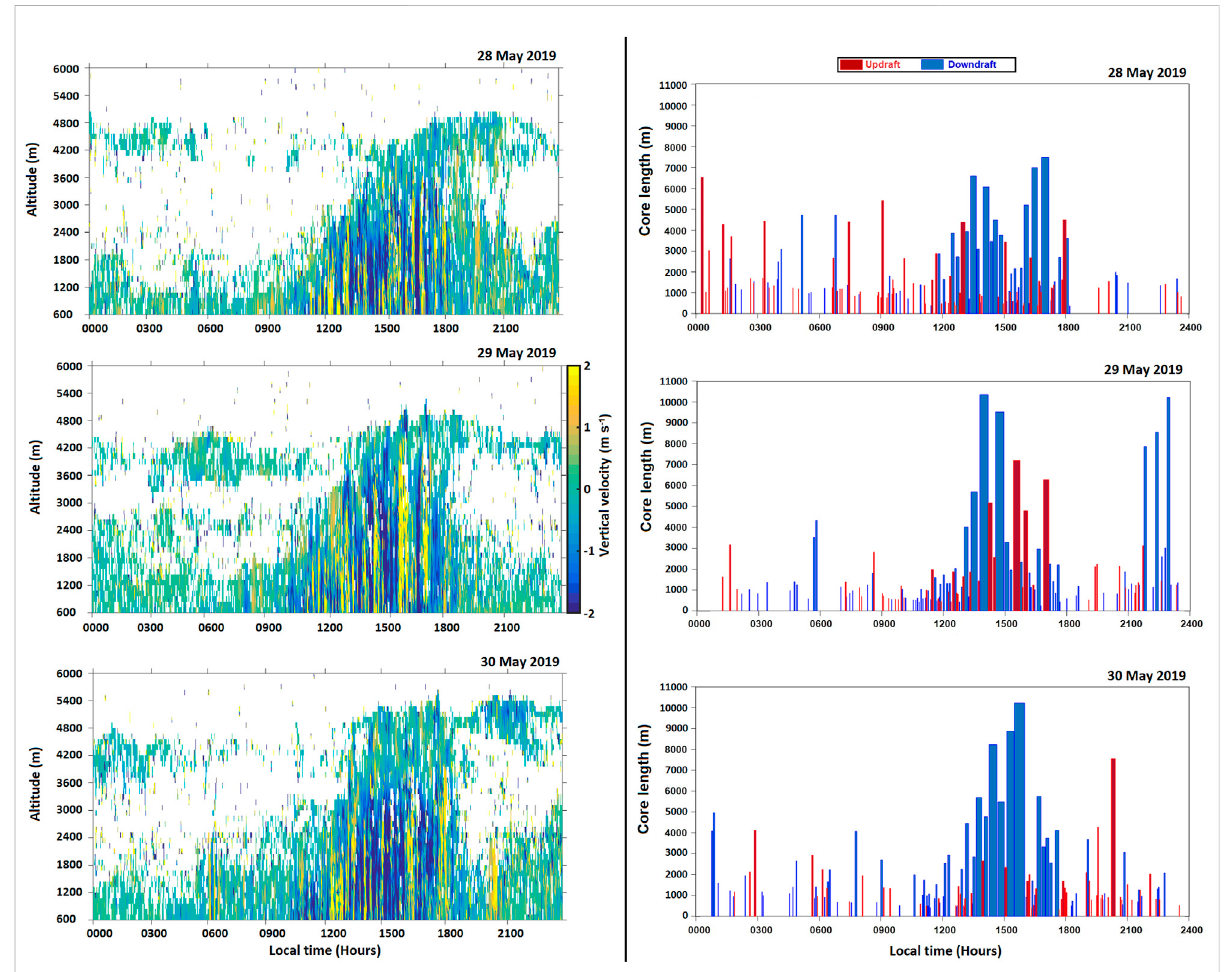
FIGURE 8 Instantaneous vertical velocity variation during 28 – 30 May 2019 (Left side panels). The adjacent panels on the right side depict the timing, duration (width) and core length (length) of updrafts (Red rectangles) and downdrafts (Blue